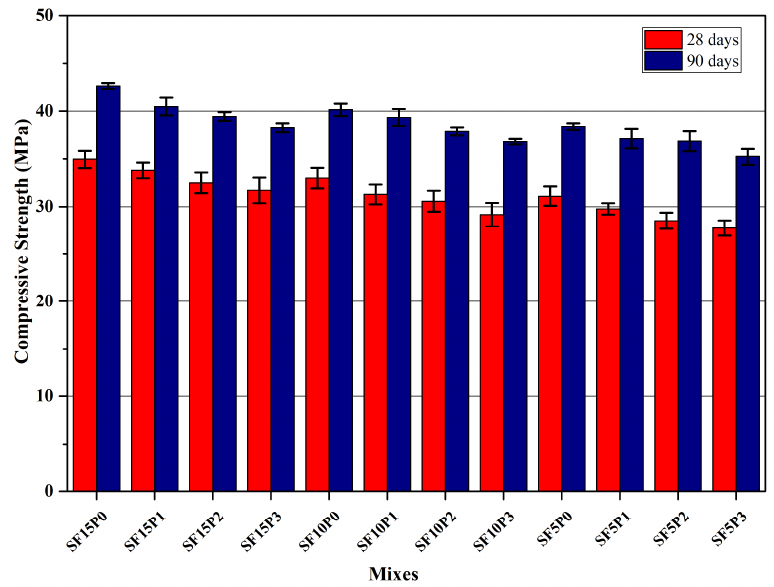
Figure 14. Compressive strength values of the MS samples .